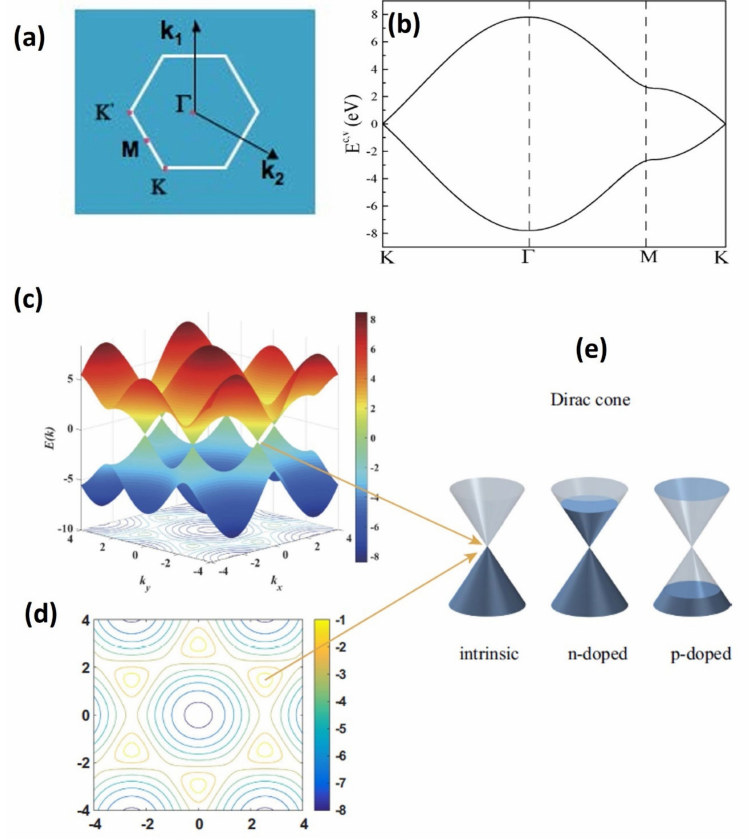
Figure 2. ( a ) Brillouin zone of graphene with high-symmetry points K, Γ , and M. The reciprocal lattice vectors, K 1 and K 2, are in Cartesian coordinates. ( b ) Band structure of monolayer graphene along the Γ K M direction. ( c ) Surface plot and ( d ) contour plot of energy dispersion in graphene. Note that there are six K points where the bandgap becomes zero. ( e ) The shape of the valence and the conduction bands of graphene resembles cone-like structures called the “Dirac cone” that meet at the Dirac point. The band position can be shifted by electron or hole doping, thus the Fermi level (E F ) is displaced to higher or lower energy, respectively, with reference to the Dirac point. (Reproduced with permission from refs